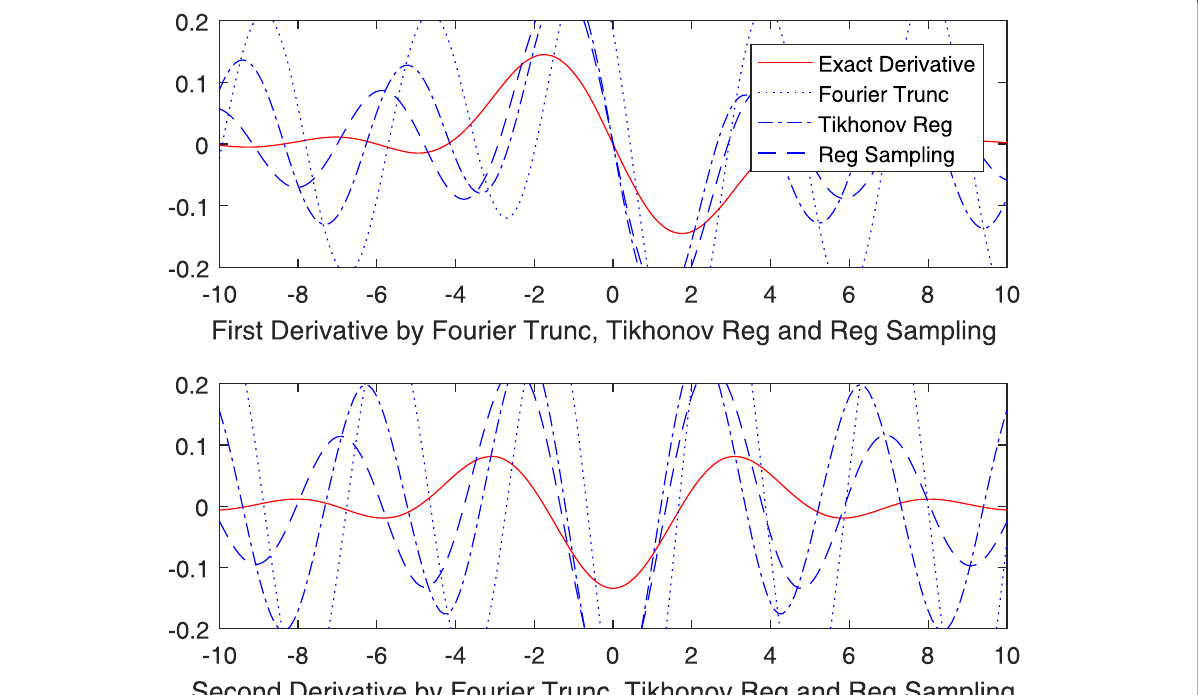
Fig. 4 The simulation results for the bipolar δ noise in Example